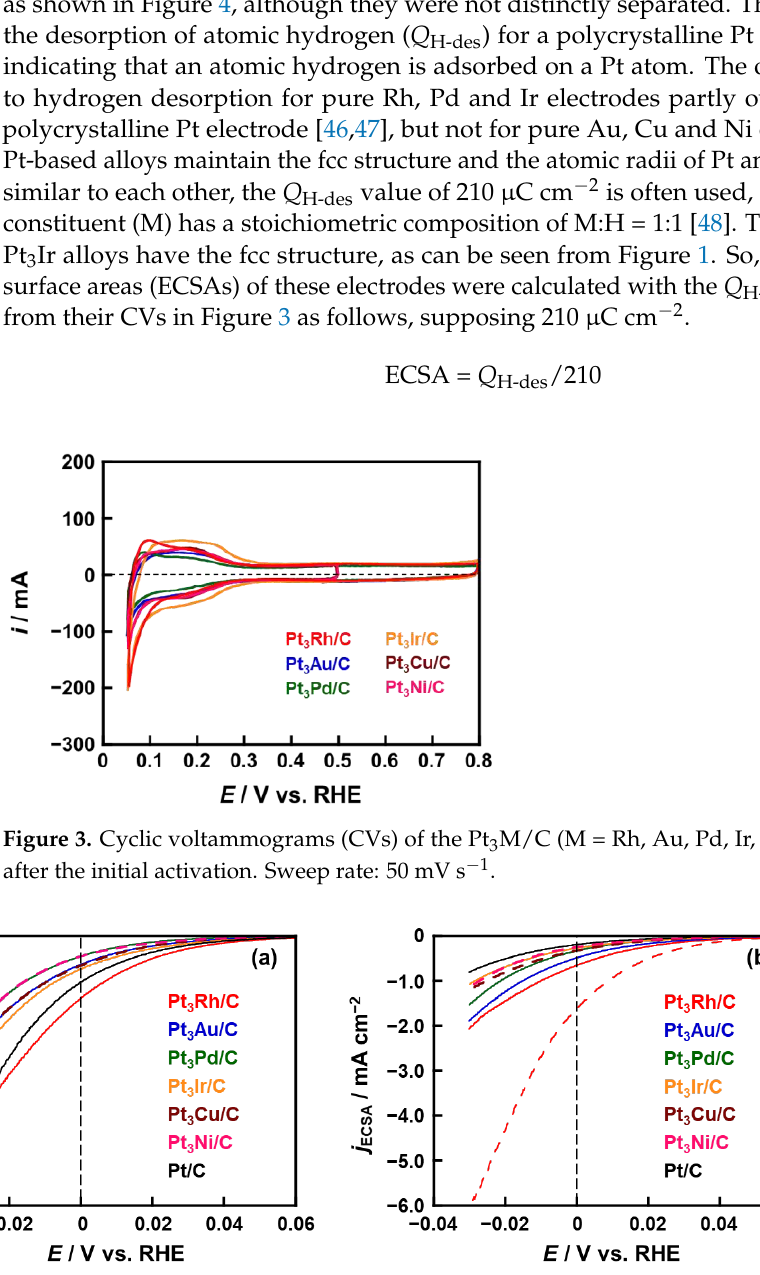
Figure 4. Linear sweep voltammograms (LSVs) of activated Pt 3 M/C (M = Rh, Au, Pd, Ir, Cu and Ni) electrodes represented by ( a ) j geo and ( b ) j ECSA . Sweep rate: 1 mV s − 1 . Solid and broken curves show the initial activation potential range of 0.05–1.2 V and 0.05–0.8 V vs. RHE, respectively. Table 3. m a , E onset , j geo,0 and Tafel slope for the activated Pt 3 M/C (M = Rh, Au, Pd, Ir, Cu and Ni) electrodes.